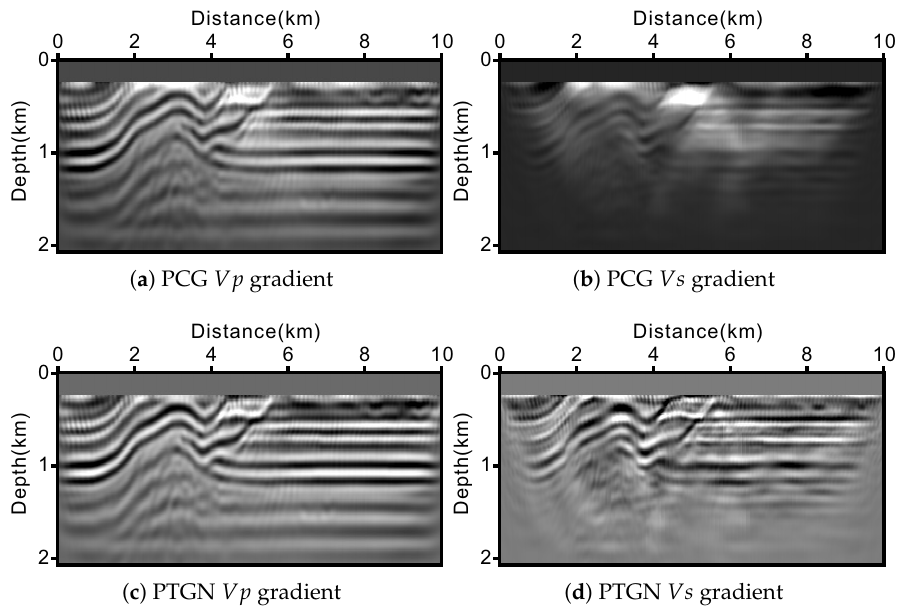
Figure 6. The multiparameter gradients of the 1 th iteration: preconditioned conjugate gradients (PCGs) of ( a ) Vp and ( b ) Vs , and preconditioned truncated Gauss–Newton (PTGN) gradients of ( c ) Vp and ( d ) Vs .